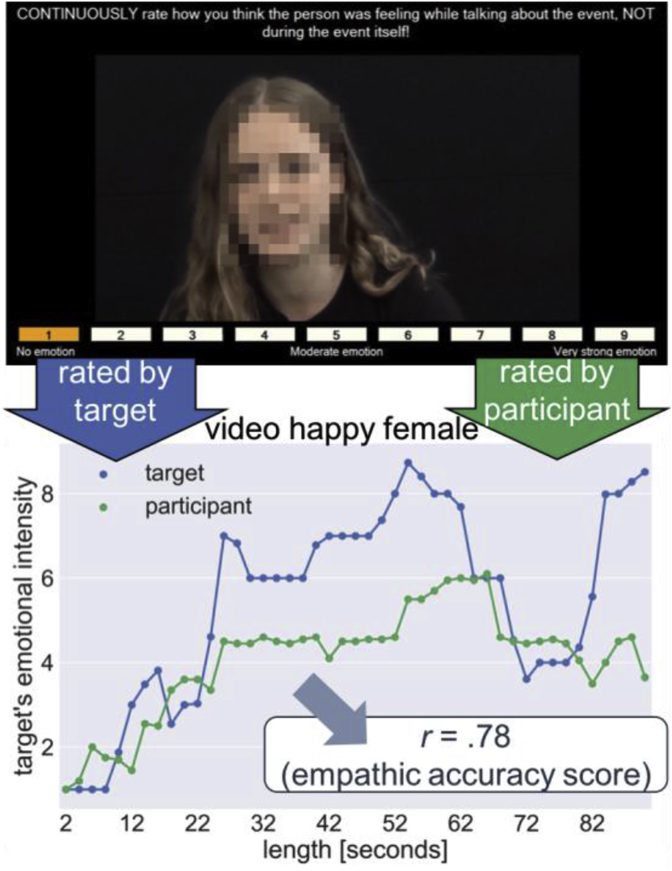
Schematic representation of the Empathic Accuracy task and continuous rating scale data. Top: example of a video clip and rating scale in the Empathic Accuracy Task. The target's identity has been disguised in this image. Bottom: Illustration of fluctuations in the target's emotional intensity, as rated by the target (blue) and an example participant's ratings (green). An Empathic Accuracy (EA) score was computed by correlating the participant's ratings and the target's ratings for each video clip.